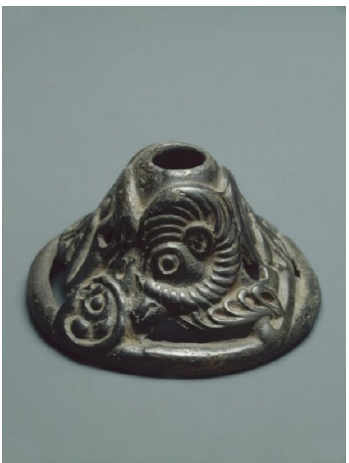
Figure 9. Bridle piece with rams clashing (SHM inv. no. 3975-343); cast bronze; Khakass-Minusinsk Basin, Krasnoyarsk Territory, Southern Siberia, Russia; Tagar culture, 5th century BC. [Image is used from www.hermitagemuseum.org (accessed 9 November 2022), courtesy of the State Hermitage Museum, St. Petersburg, Russia].